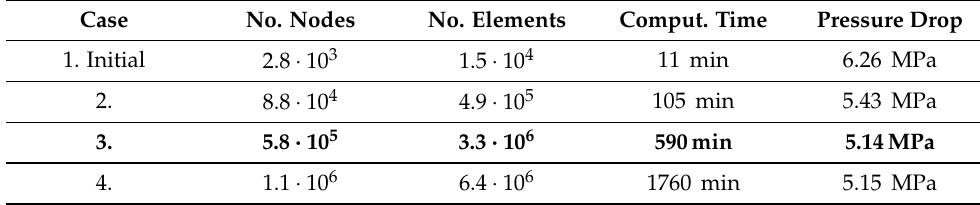
Table 3. Mesh quality